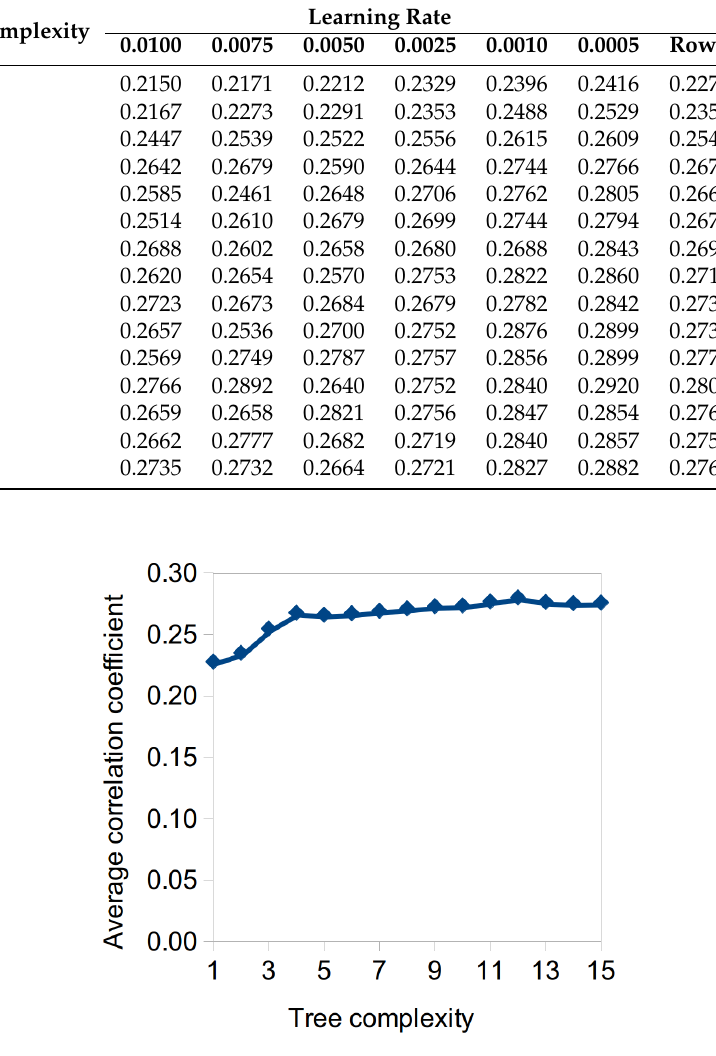
Figure A1. Mean correlation coefficient across learning rates (0.01–0.0005) for 10-fold cross-validation of the BRT model for forest conversion in the interval 2001–2011 evaluating all learning rates from 0.01–0.0005 paired with all tree complexities from